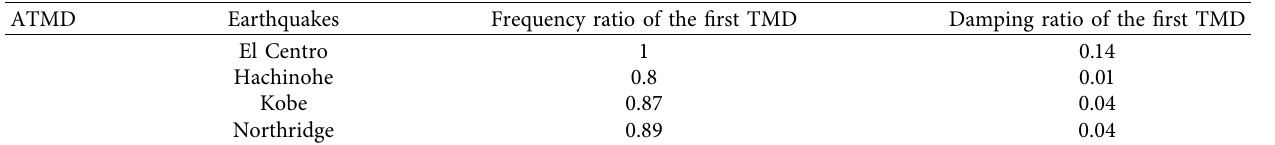
Table 3: Damping ratio and frequency ratio of